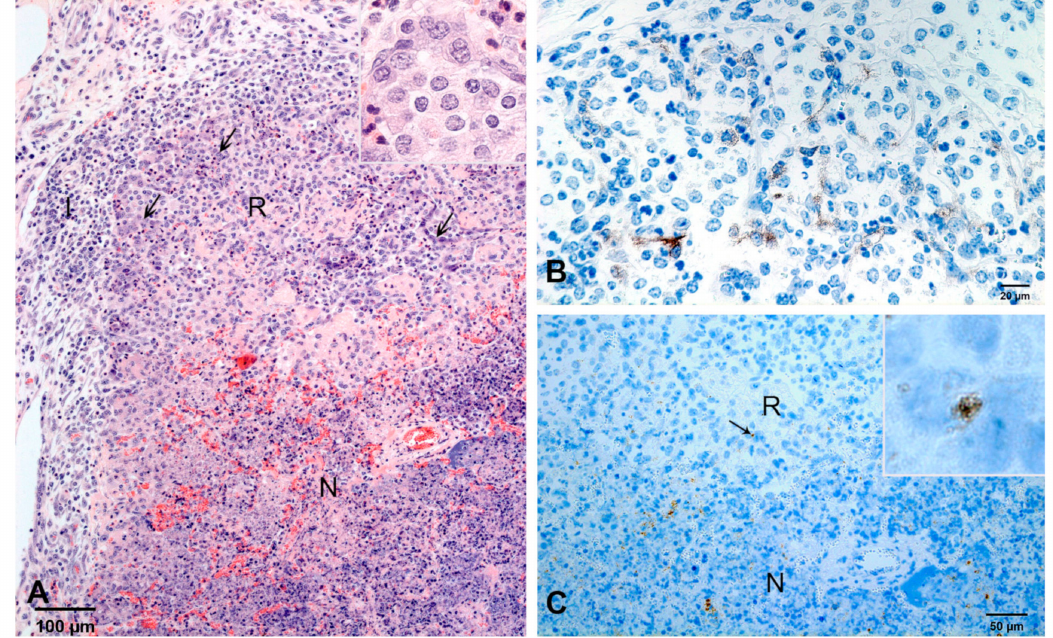
Figure 5. Pulmonary lesions at 7 dpi. ( A ) A few, small groups of epithelial cells (arrows, examples) form a small zone of regeneration (R) at the periphery of a necrosis (N). There is an infiltrate (I) of macrophages, lymphocytes and plasma cells in the adjacent interlobular septum. Inset: higher magnification of a rudimentary alveolar wall. HE-stain. ( B ) Higher magnification of the zone of regeneration. A few cells are weakly positive for cytokeratin (brown). IHC, cytokeratin. ( C ) Chlamydial inclusions (brown) predominate in the necrosis (N) and are rare (arrow) in the zone of regeneration (R). Inset: higher magnification of a chlamydial inclusion in the zoe of regeneration. IHC,